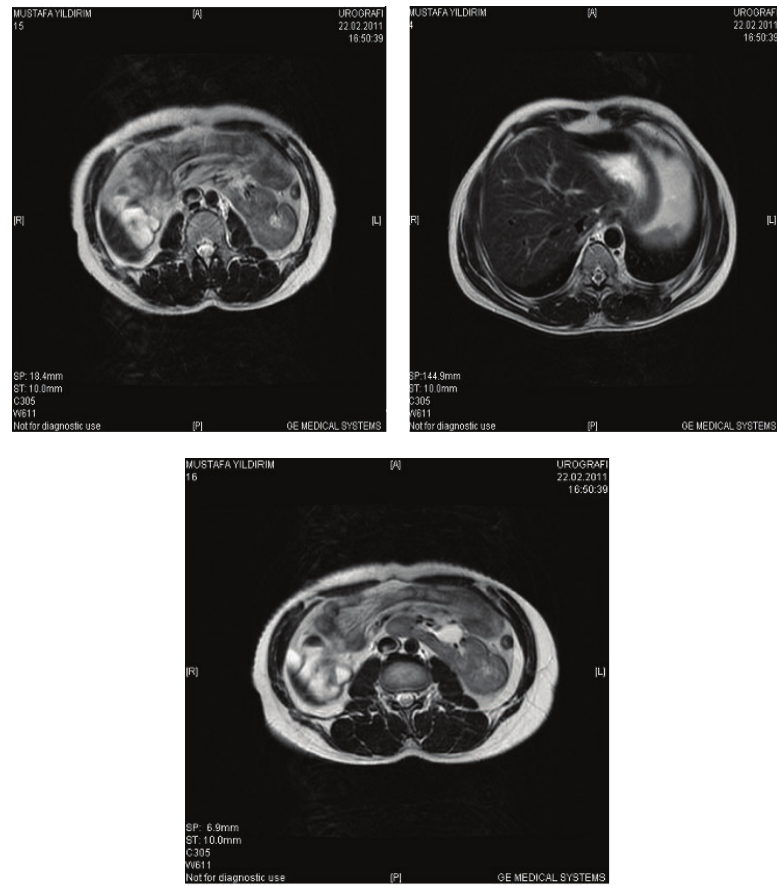
Figure 2: Abdominal CT showing cross ectopy and malrotation of the right